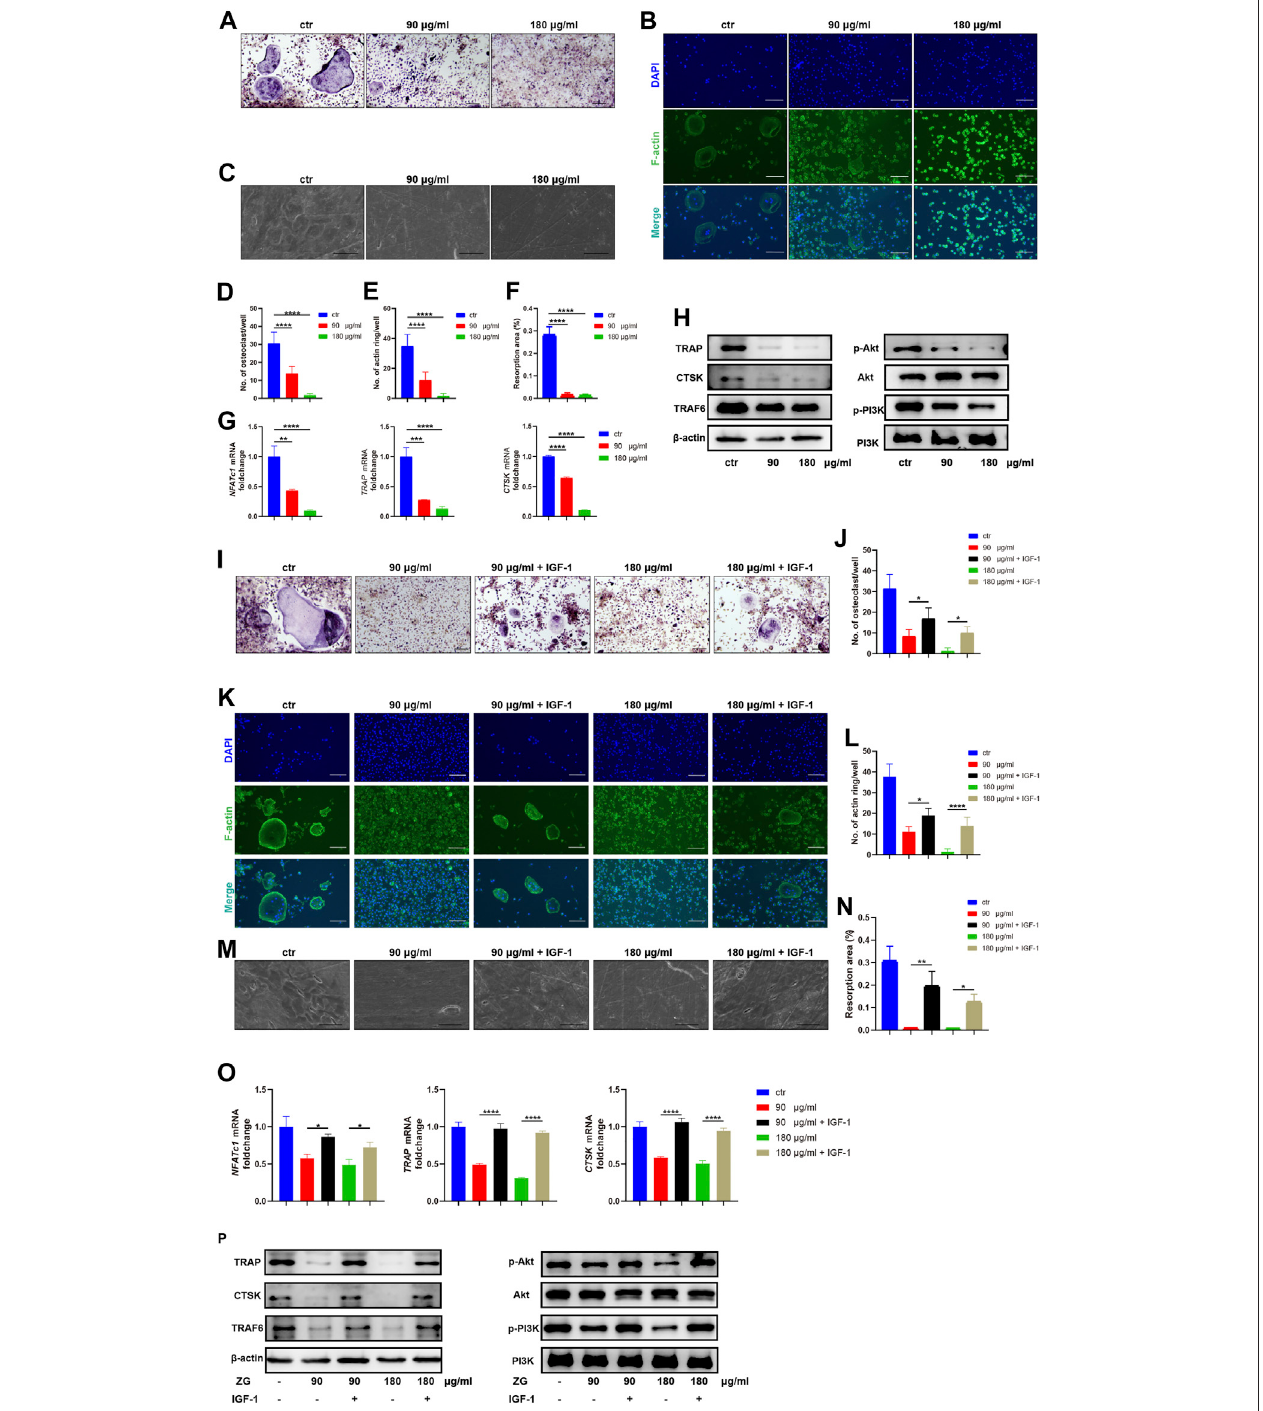
FIGURE3| ZGinhibitsthePI3K/Aktsignalingpathwaytoreduceosteoclastdifferentiation invitro . (A – C) TherepresentativeimagesofTRAPstaining (A) ,phalloidin staining (B), andresorptionpits (C) forBMMsatday10aftertreatmentwithvehicle(ctr)andZGat90or180 μ g/mlconcentration,respectively. (A,B) Scalebar (cid:2) 100 μ m, (C) Scale bar (cid:2) 20 μ m. (D) The number of multinucleated osteoclasts with TRAP-positive staining per well in indicated groups. (E) The number of actin ring per well in indicated groups. (F) Quanti fi cation for the percentage of resorption pit area relative to total bovine bone slices area in indicated groups. (G) Q-PCR analysis for mRNA expression of osteoclast differentiation marker genes including NFATc1, TRAP, and CTSK in BMMs treated with vehicle (ctr) and ZG at 90 or 180 μ g/ml concentration, respectively. (H) Western blot analysis for protein levels of osteoclast differentiation markers (TRAP, CTSK, and TRAF6) and PI3K/Akt signaling pathway